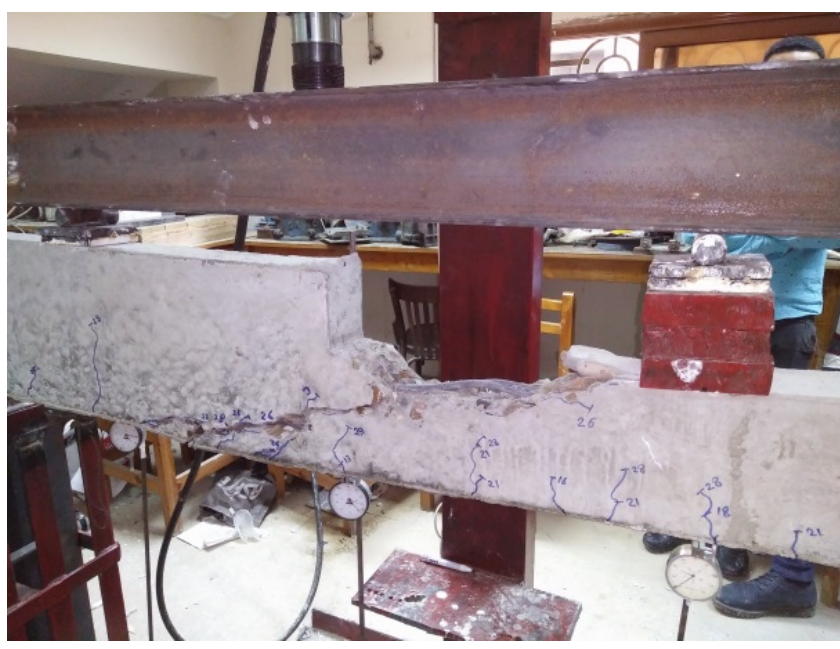
Figure 10. Crack pattern of beam B1 *.